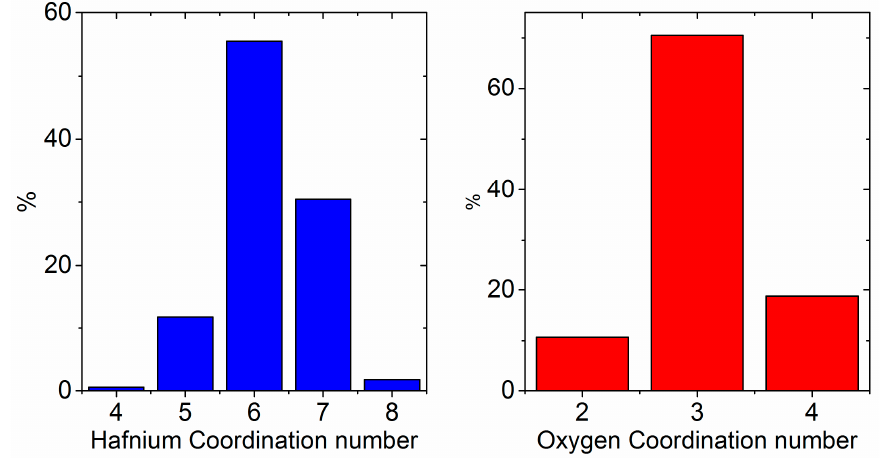
Figure 10. Probability distribution of coordination numbers corresponding to the local environments of Hf and O in amorphous HfO 2 nanoparticles.